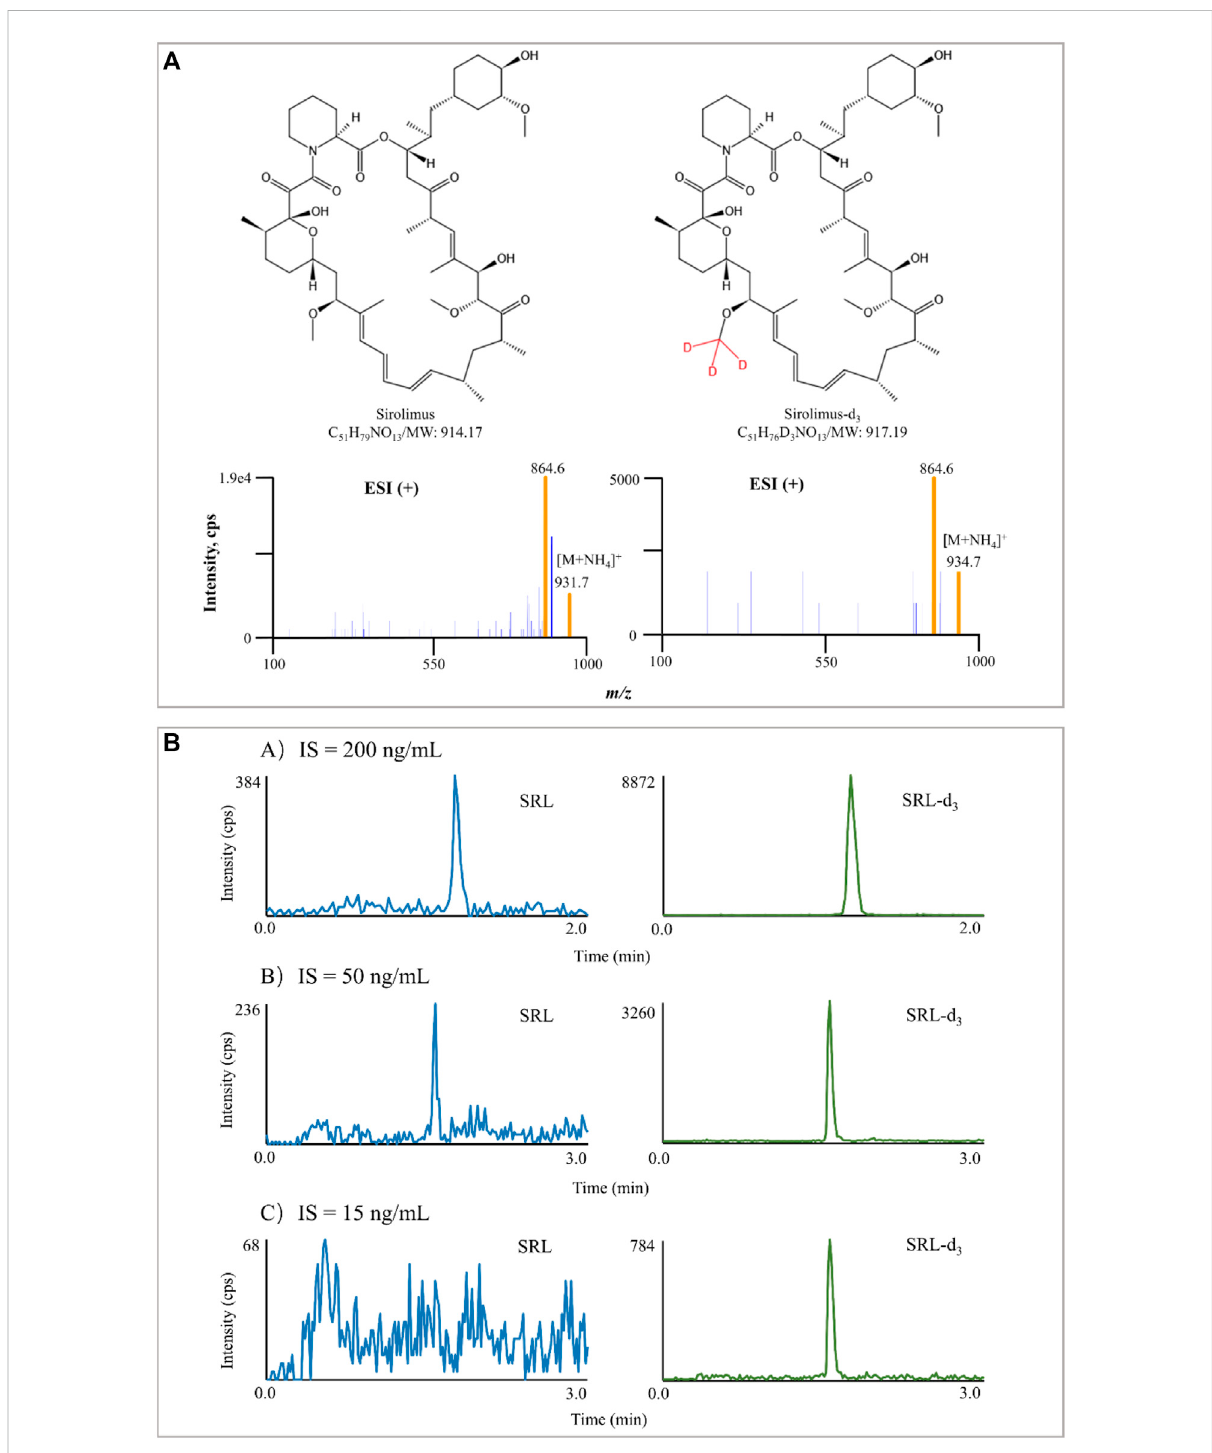
Typical MS/MS product ion spectra of SRL and SRL-d 3 . The experiment was performed under Manual Tune mode by a syringe infusing the standard solution of SRL and SRL-d 3 (100 ng/ml) at a rate of 5 μ l/min (A) . Interference of IS in blank samples spiked with IS only. The difference in chromatographic run time in (A) is due to the different gradient (B)